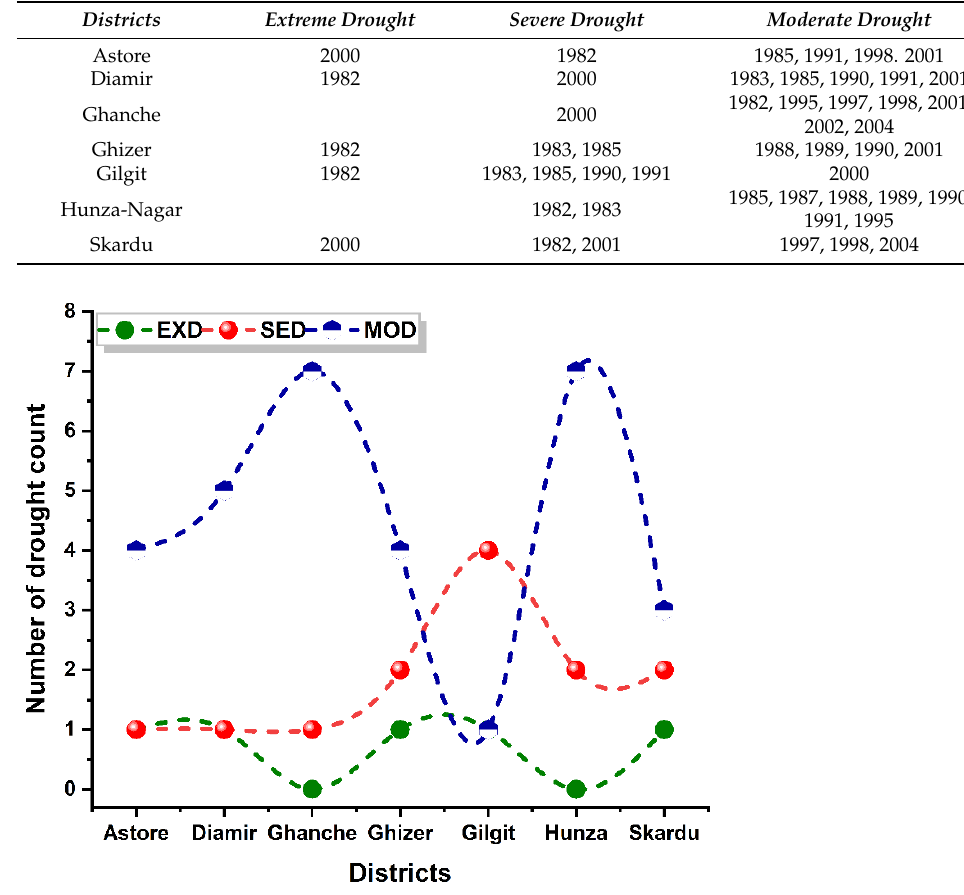
Table 5. Frequency of drought for 12-Month SPI.